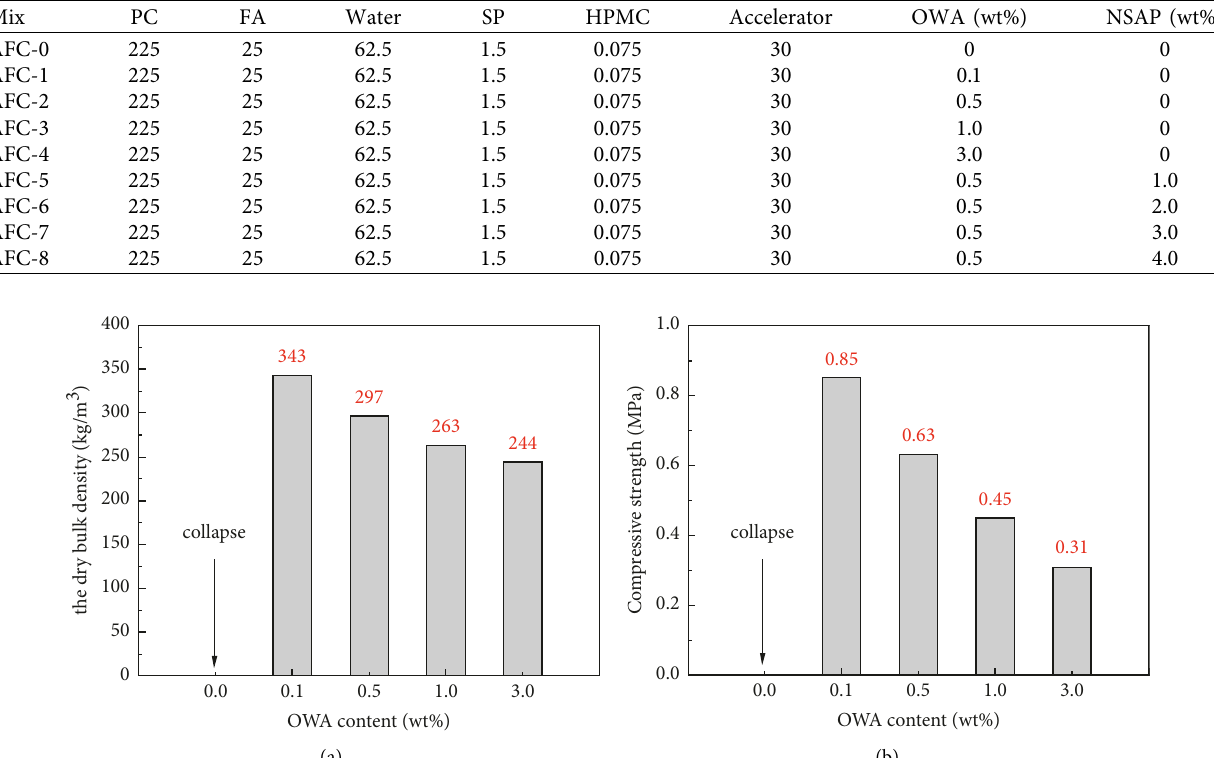
Table 2: The mix designs of AFC (kg/m 3 ).